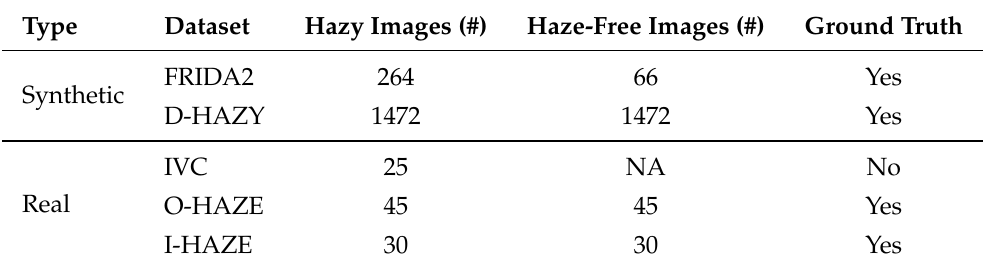
Table 4. Summary of the datasets employed for evaluation. NA stands for not